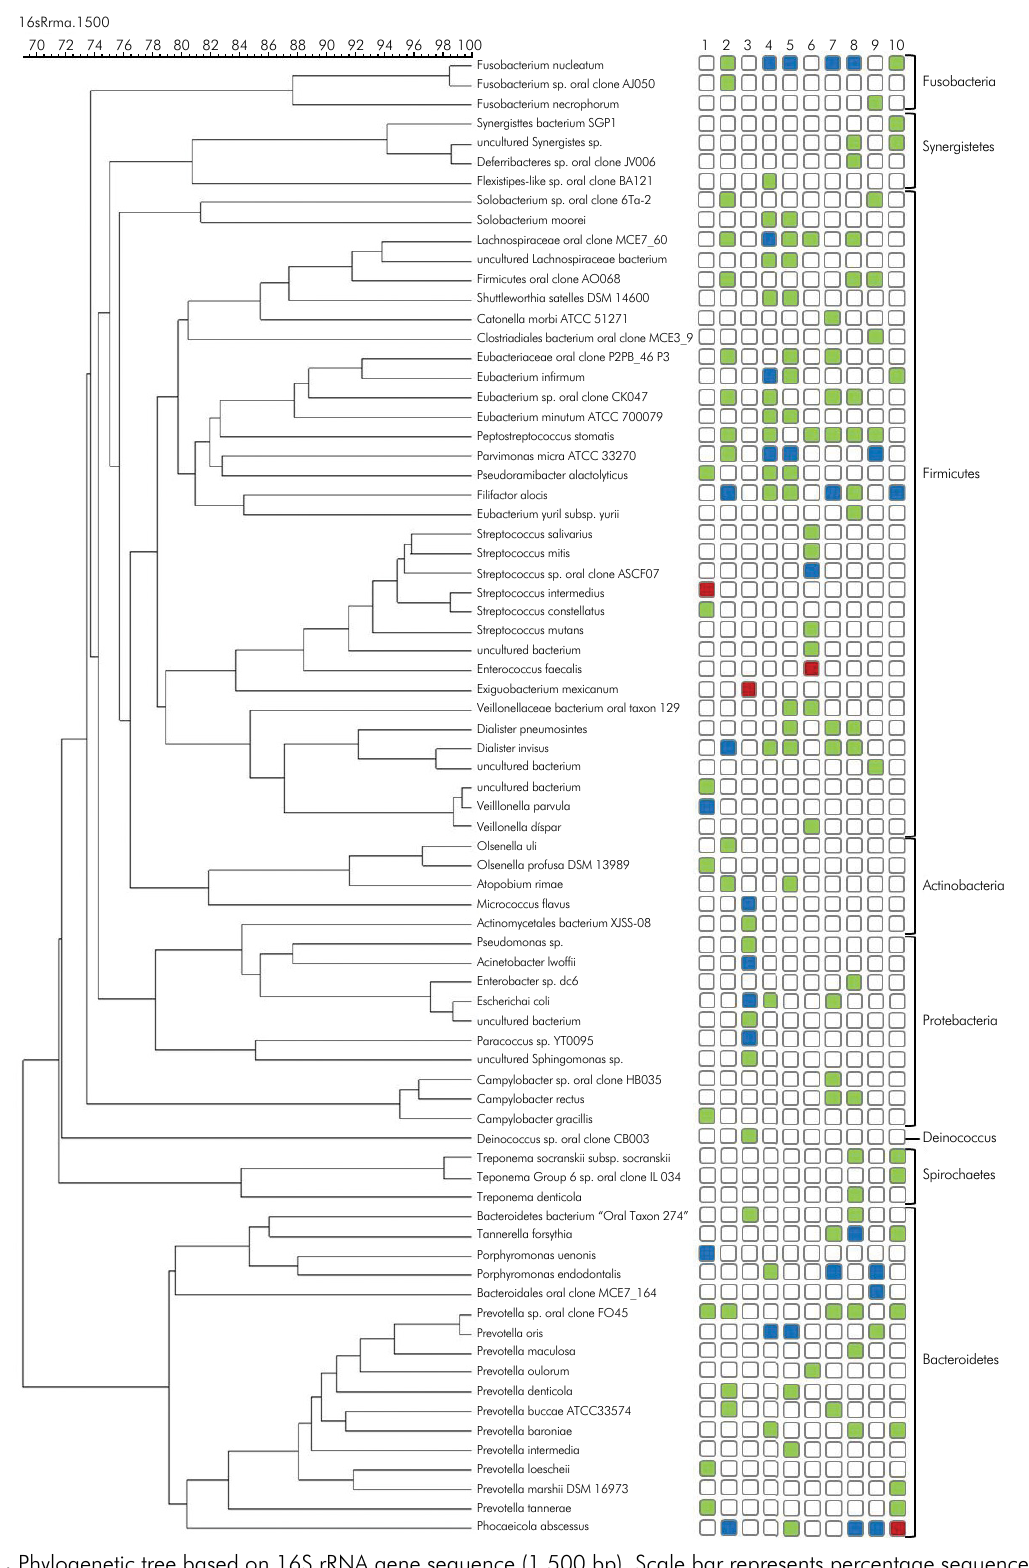
Figure 1. Phylogenetic tree based on 16S rRNA gene sequence (1,500 bp). Scale bar represents percentage sequence similarity. The column of boxes represents the bacterial profile of each patient (n = 10) and proportion is indicated by the following colors: white (absence), green (< 10%), blue (10%–30%), and red (>